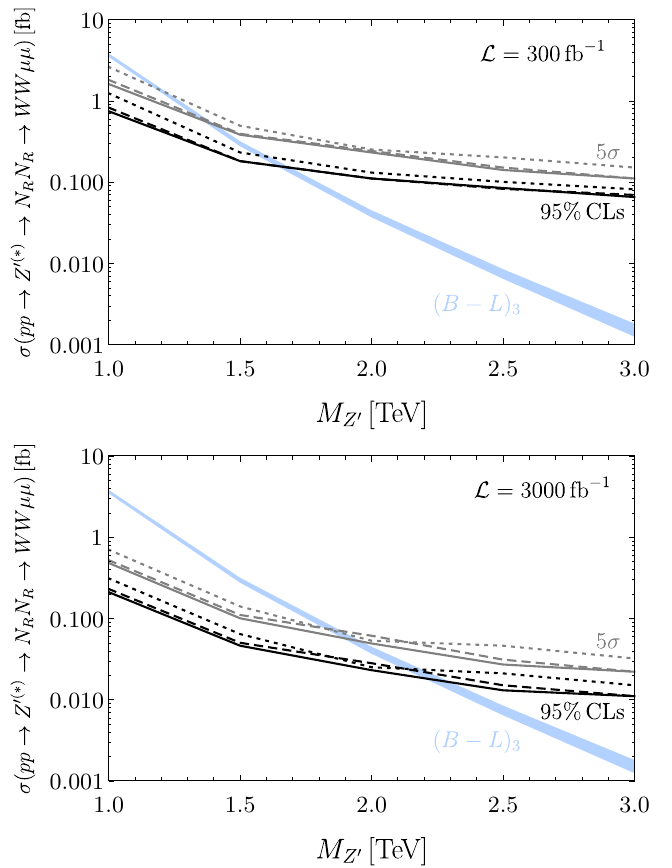
p Figure 5 . Projected sensitivity with 300 fb (cid:0) 1 (top) and 3000 fb (cid:0) 1 (bottom) at s = 14 TeV. The solid, dashed and dotted lines correspond to M N = (1 = 3 ; 1 = 4 ; 1 = 5) (cid:2) M Z 0 respectively. The R blue band shows the expected cross-section and its associated uncertainty in the ( B (cid:0) L ) 3 model, assuming g = 0 : 6 and M N = M Z 0 = R